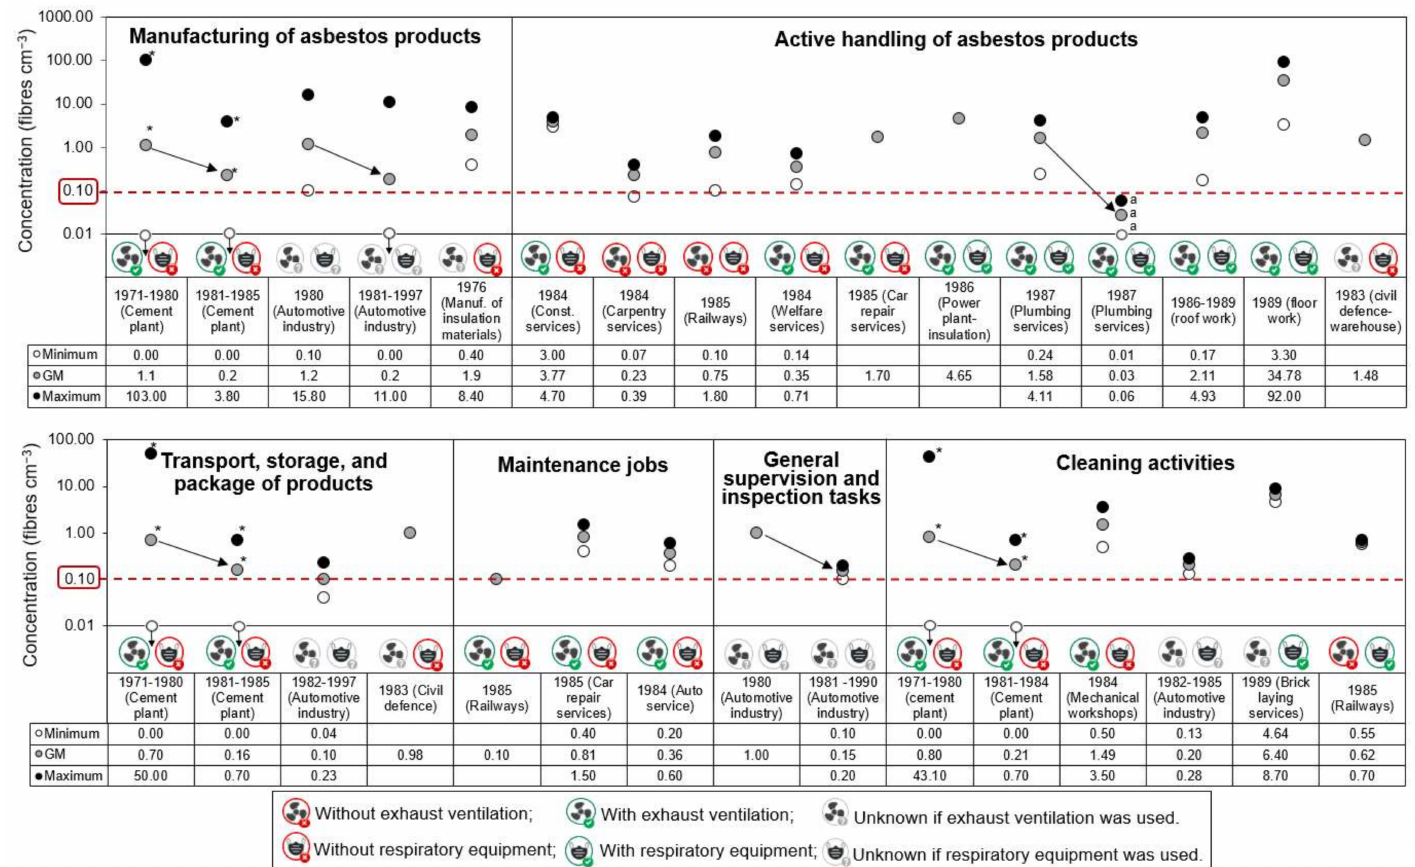
Figure 4. Personal exposure asbestos concentrations in each occupational category for the period 1971–1980 or 1981–1997 compared to the current 8-h TWA health guideline value (horizontal dashed line). The white, grey and black dots correspond to minimum, geometric mean (GM) and maximum asbestos concentration, respectively. Concentrations = 0 fibres cm − 3 are represented in y = 0.01 with an arrow towards down. All the personal measurements which workers used respiratory protective equipment were taken outside the mask unless specified; *: Mechanical ventilation used from 1977 onwards; a Measurements taken inside the respiratory protective equipment; Manuf.: manufacturer; Const.: